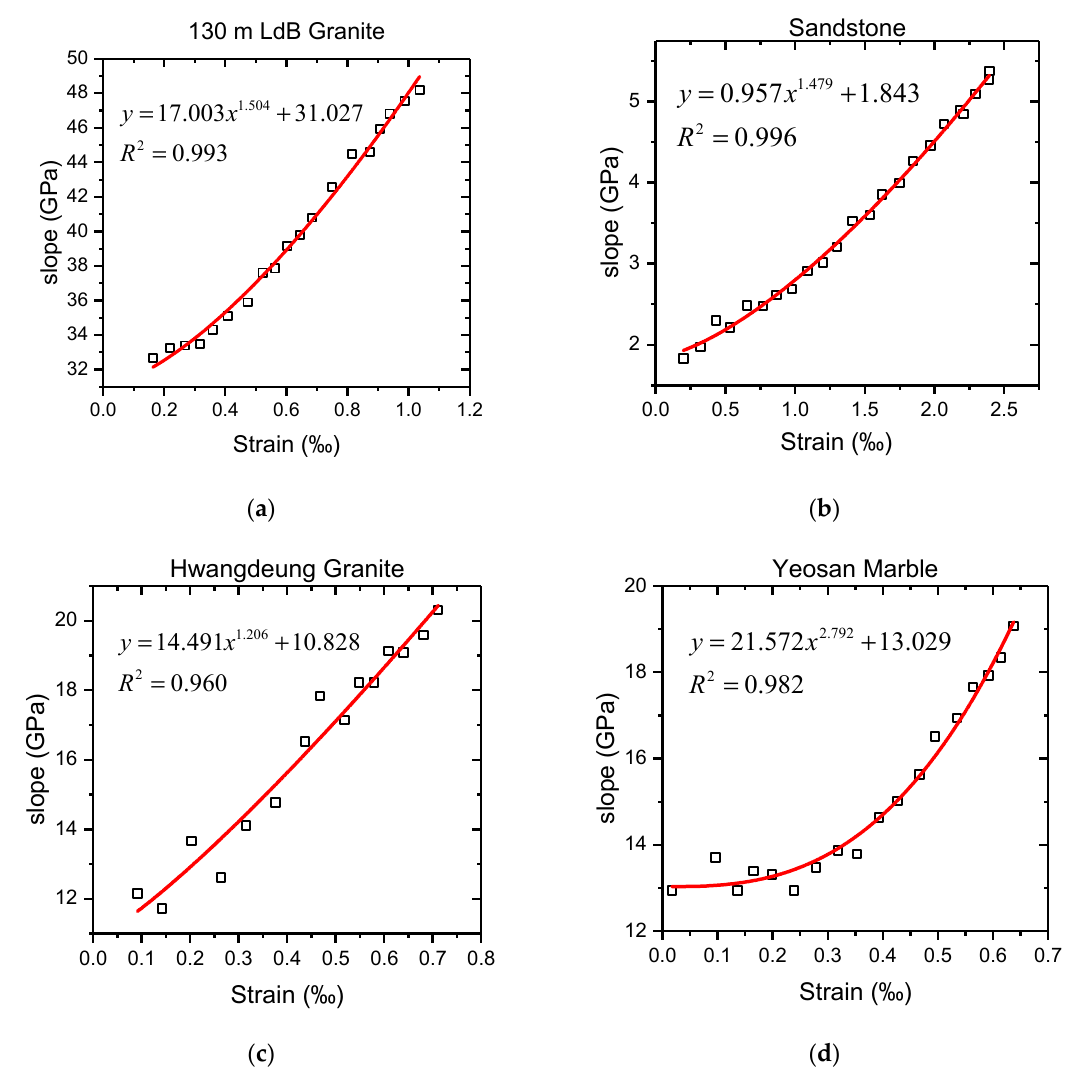
Figure 5. The variation law of k. ( a ) Eberhardt et al. [49]; ( b ) Gao et al. [52]; ( c ) Chang et al. [53]; ( d ) Chang et al. [53].